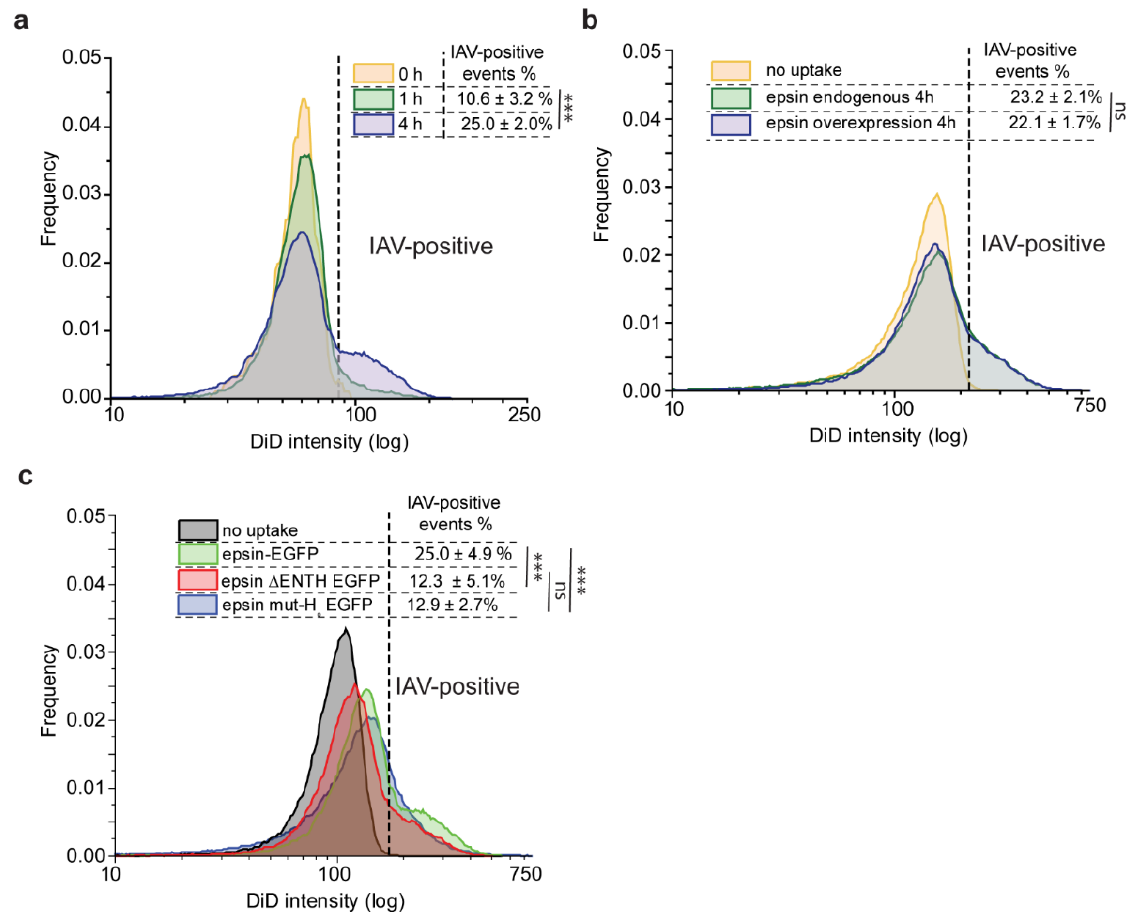
Figure 3. Internalization of IAVs is disrupted in cells overexpressing epsin without functioning ENTH domain. ( a ) Flow cytometry histograms showing IAV uptake at 0 h (no infection), 1 h and 4 h in RPE cells overexpressing epsin-EGFP. ( b ) IAV uptake (4 h) in RPE cells with endogenous expression of epsin and overexpression of epsin WT. ( c ) IAV uptake (4 h) in RPE cells stably expressing epsin-EGFP, epsin ∆ ENTH EGFP and epsin mut-H 0 EGFP. Percentage of cells with IAV internalization is shown in the inset. Experiments were repeated n = 3 and standard deviation is provided in the inset. ns represents not significant. *** represent p < 0.001.